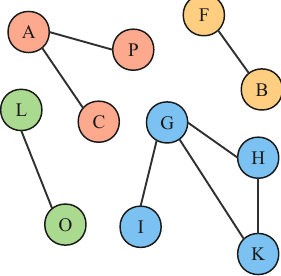
Figure 3. Disconnected network.